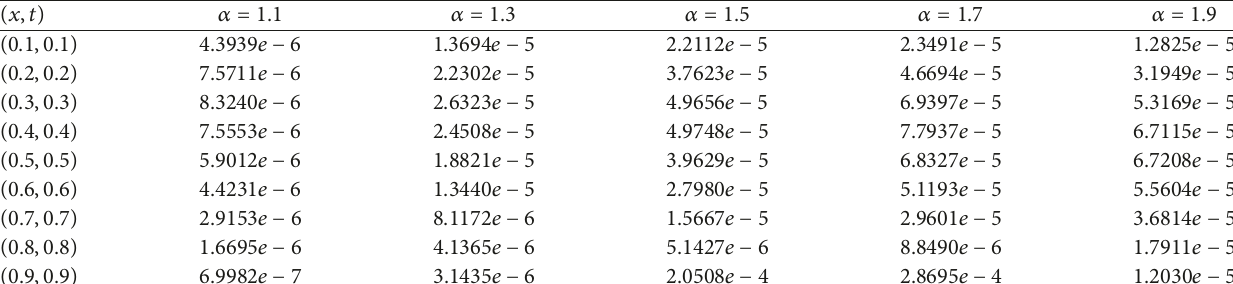
Table 2: The absolute error for Example 1 for some different values 1 < 𝛼 ≤ 2 at some different points in